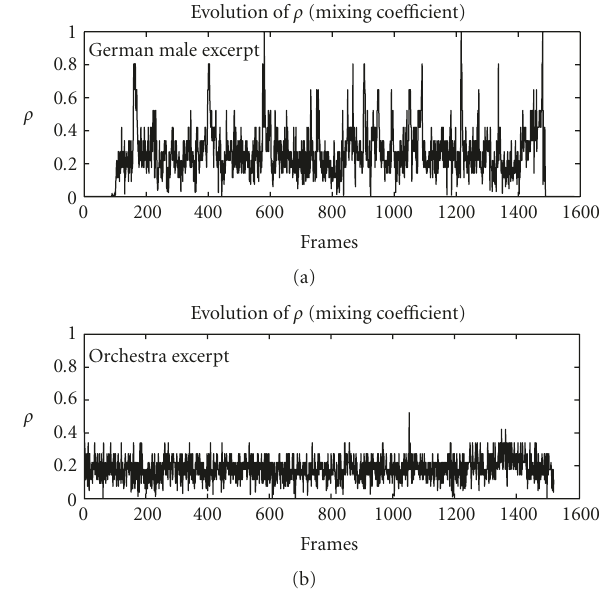
Figure 5: Evolution of the mixing factor for German male (a) and Orchestra (b).